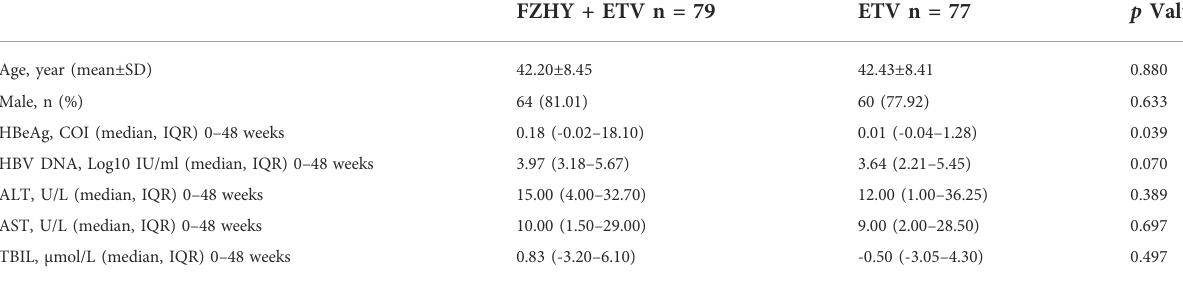
TABLE 2 The therapeutic outcomes of the two groups after 48 weeks